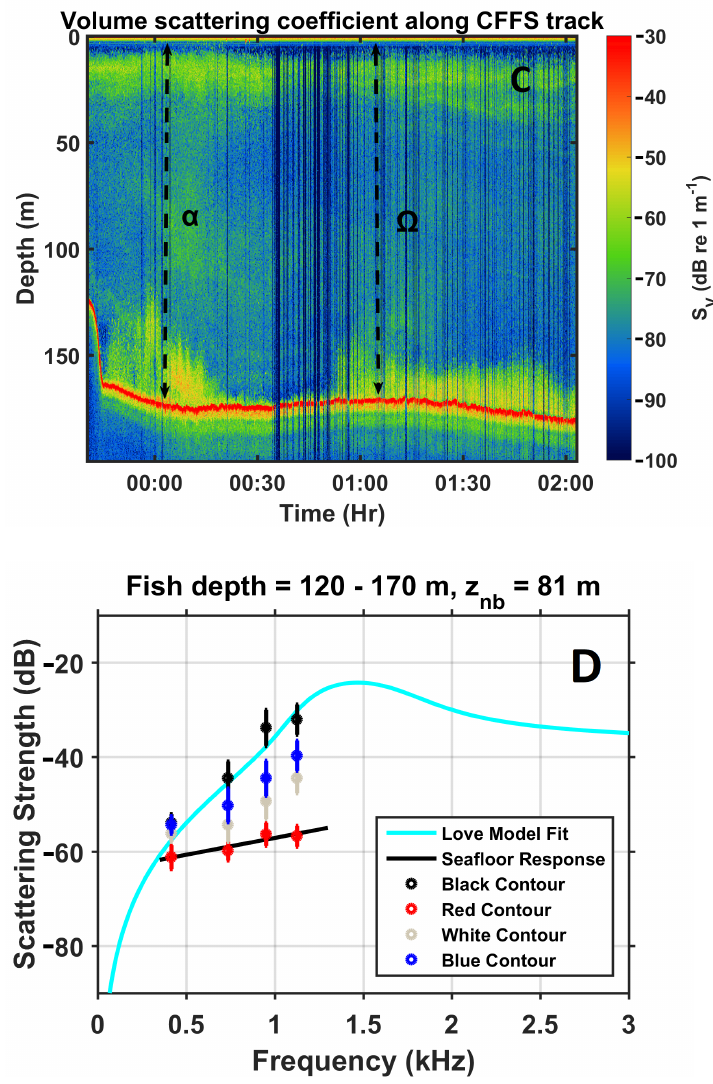
Figure A1. Discrimination of fish from seafloor scattering regions by Kullback–Leibler Divergence. ( A ) OAWRS 950 Hz scattering strength measured on 4 October, at 00:16:15 EDT, dominated by scatter- ing from massive fish shoal extending for roughly 15 km, part of which is within the black-contoured region, compared with returns within red-contoured region dominated by seafloor scattering, white- contoured region with low population density fish presence and blue-contoured region containing a dense fish shoal. ( B ) Frequency variation of Kullback–Leibler divergence in bits of information in comparison between black contoured region with red, white and blue contoured regions respectively. For dense fish versus seafloor in black versus red-contoured region comparison, overall Kullback– Leibler divergence is greatest and monotonically increases with frequency and reaching a maximum near the swimbladder resonance peak. Kullback–Leibler divergence is overall the least in comparison of two densely populated fish regions, i.e., those within black and blue contours. ( C ) Echosounder tracks shown with blue line on 4 October at midnight hours and ( D ) scattering strength versus frequency for each contoured region, dense fish (black and blue data points), seafloor (red data with black mean line), low population density fish (gray data points for white-contoured